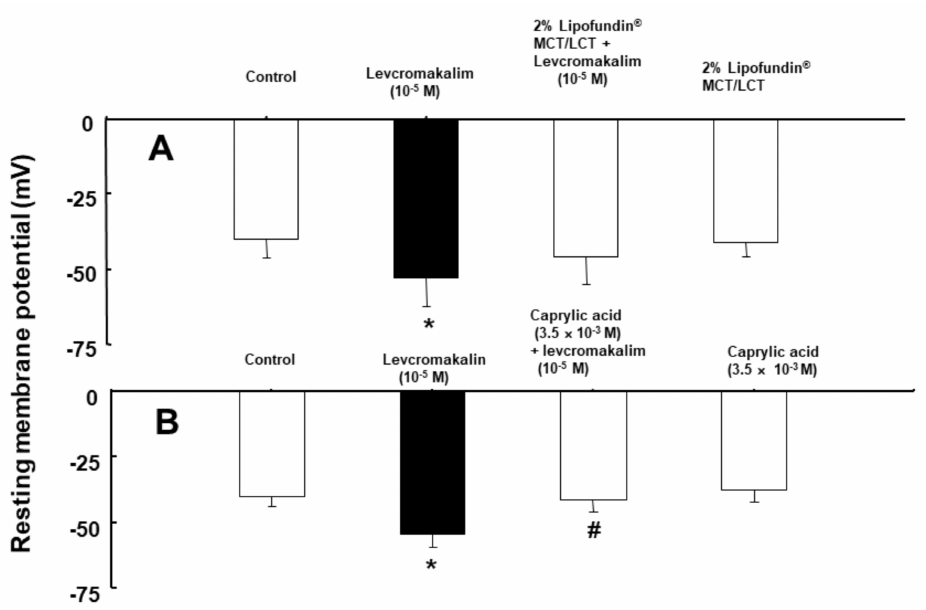
Figure 7. E ff ect of Lipofundin MCT / LCT ( A ; n = 6~8) and caprylic acid ( B ; n = 8) on levcromakalim- induced membrane hyperpolarization in rat vascular smooth muscle cells. Membrane potentials were analysed in two di ff erent sets of experiments. Each bar is the mean ± SD of three repeated experiments. A: * p < 0.05 versus control. B: * p < 0.001 versus control. # p < 0.001 versus levcromakalim alone. − 5 Levcromakalim (10 M) did not significantly alter the phosphorylation of endothelial nitric oxide synthase (eNOS) in human umbilical vein endothelial cells (HUVECs) (Figure 8A). A high concentration − 3 of caprylic acid (3.5 × 10 M) induced PKC phosphorylation in rat aortic VSMCs (Figure 8B: p < 0.001 versus control). Lipofundin MCT / LCT (2%) decreased cGMP formation in endothelium-intact rat aortae (Figure 8C: p < 0.05 versus